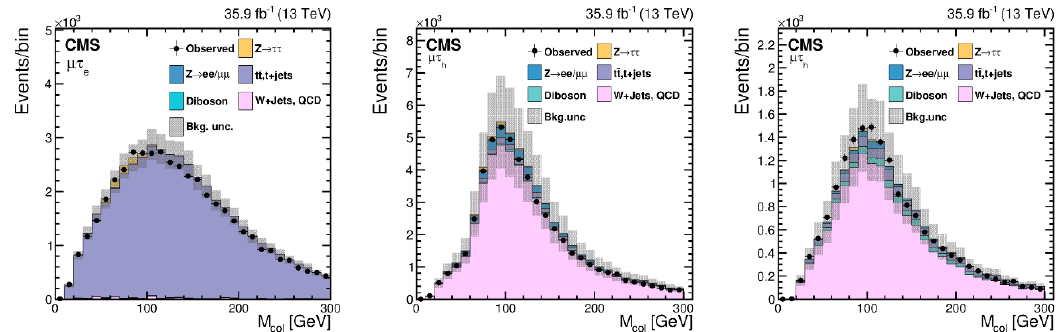
Figure 3 . M col distribution in tt enriched (left), like-sign lepton (central), and W + jets enriched (right) control samples de(cid:12)ned in the text. The distributions include both statistical and systematic